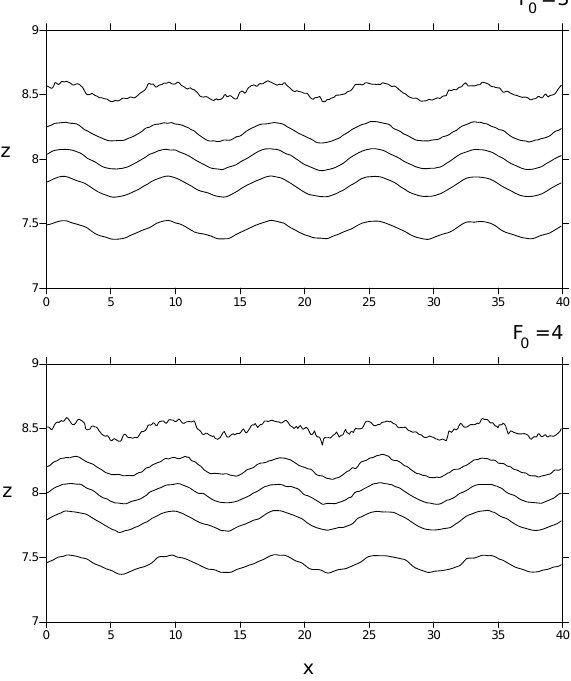
Fig. 10. Instantaneous density contours obtained in DNS at t = 300 with turbulence forcing on ( F 0 = 3, top and F 0 = 4, bottom) and initially excited IW with wavelength λ = 4. Density contours in each panel are (from bottom to top) 1.1, 1.3, 1.5, 1.7, 1.9.